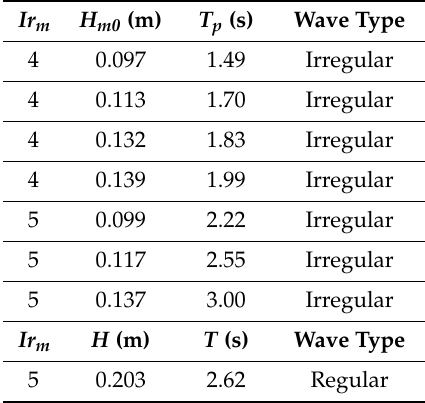
Table 1. Wave characteristics of the physical tests used in this study.